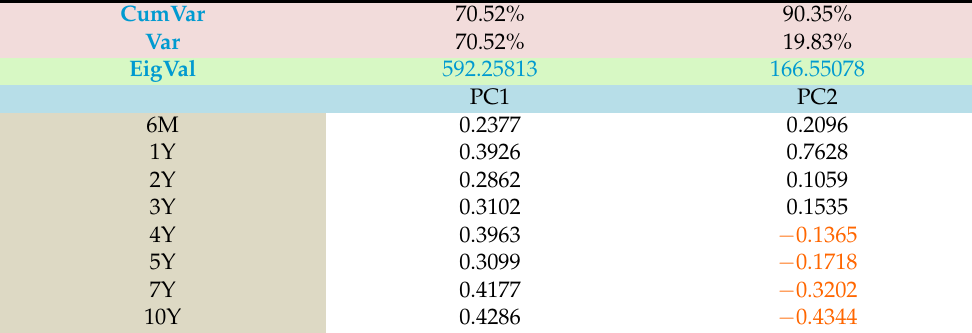
Table 13. Factor loadings , eigenvalues, and variances explained by the first two PCs on 28 February 2020. Source: Bloomberg, own computation of PCs with the use of a VBA add-in developed by Leonardo